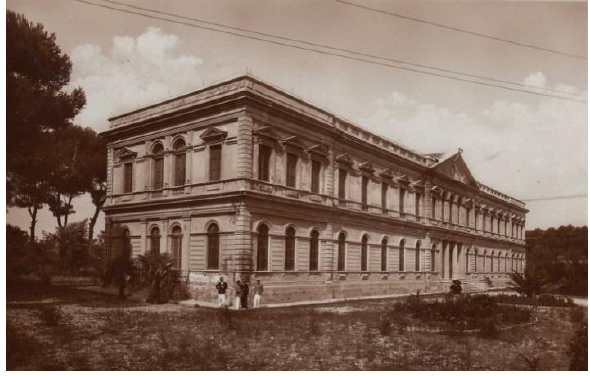
Figure 1 Tito Acerbo photo of